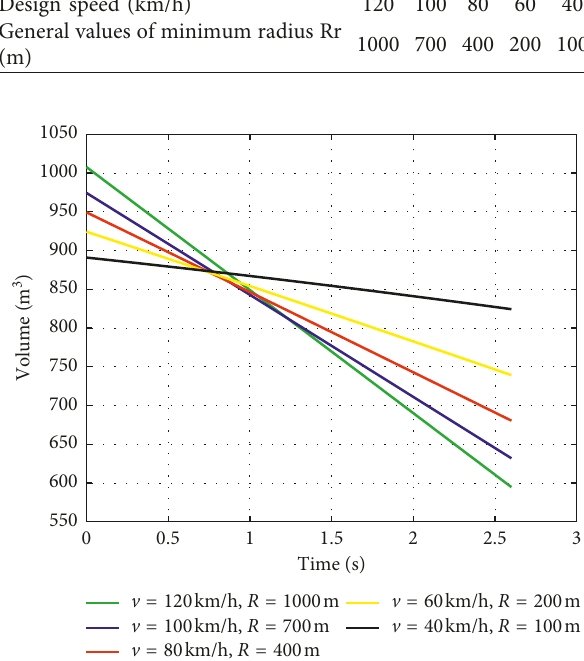
Figure 6: The volume of visibility window as function of speed on the inner curved highway (for details, refer to the